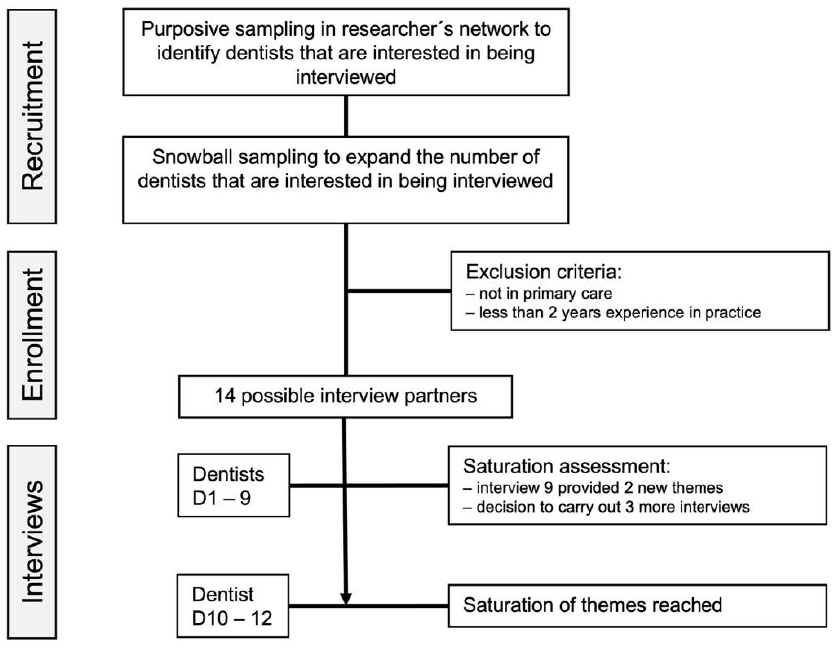
Figure 3. Sampling Figure 3. Sampling strategy.